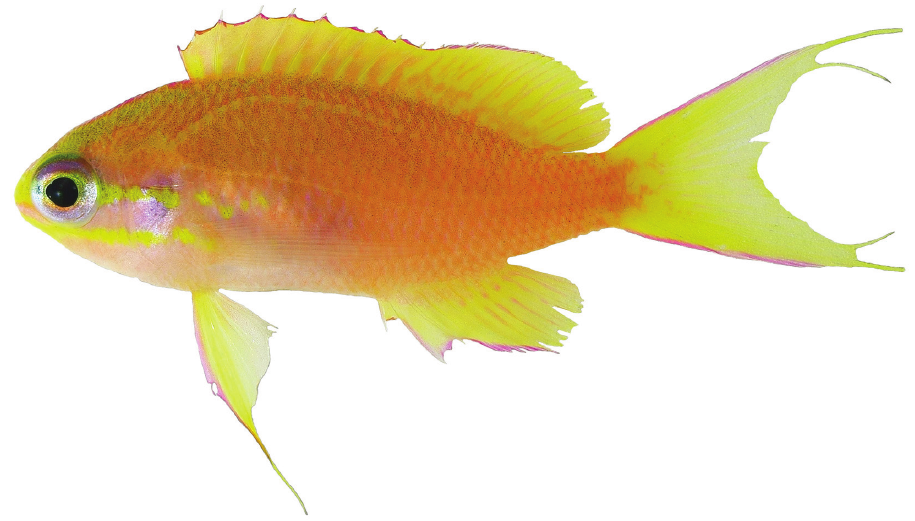
Figure 2. Paratype of Tosanoides obama (USNM 440451), collected at a depth of 92 m off Pearl and Hermes Atoll, Northwestern Hawaiian Islands. Photo by R. L.